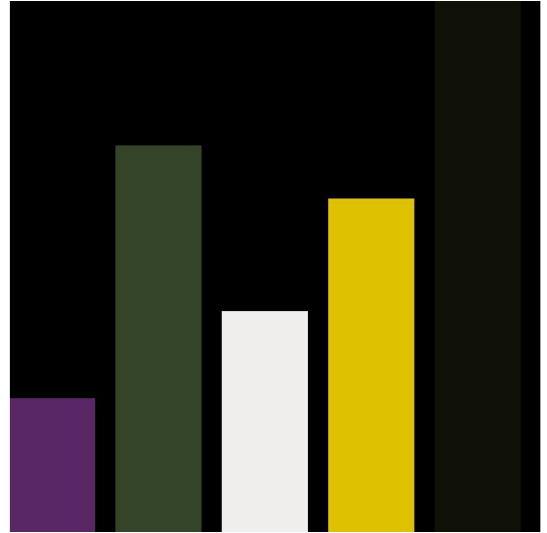
Figure 4. Analysis chart of color composition of the original